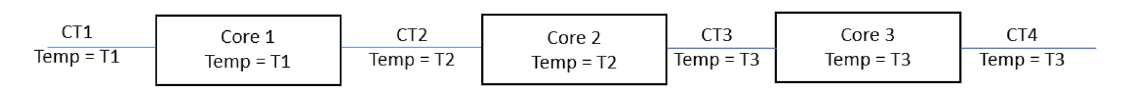
Fig. 1 Sketch of the experimental set-up/flooding rig with 3 cores and capillary tubed is series. The injection direction is from left to right, from low to high temperature. T1 was 20 °C in all the experi-